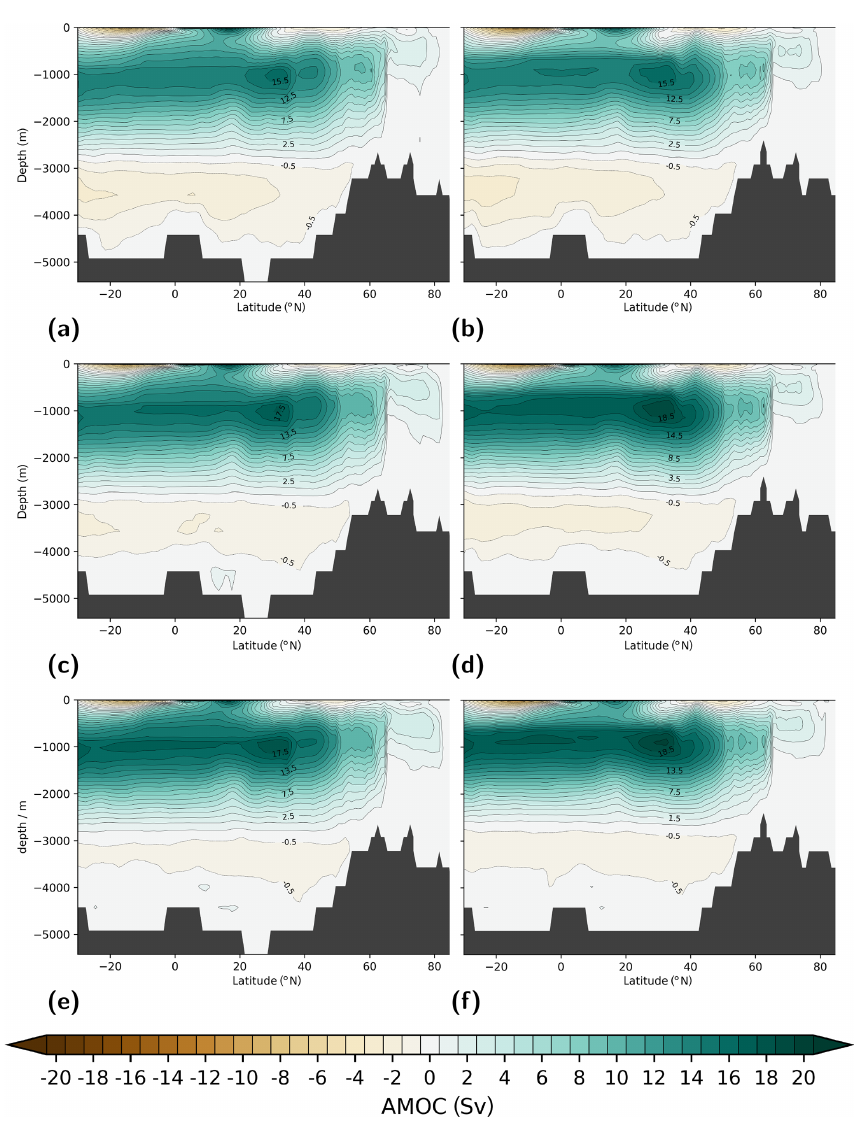
Figure 6. Atlantic Ocean Meridional Overturning Circulation (AMOC) in Sverdrups (1Sv ≡ 10 6 m 3 s − 1 ) visualised via the basin-wide zonal- and time-integrated stream function. Shown are (a) E280, (b) Eoi280, (c) E400, (d) Eoi400, (e) E560, and (f) Eoi560. Positive AMOC values illustrate clockwise circulation from the viewpoint of Europe and Africa. Dark grey shading illustrates bottom topography zonally averaged across the